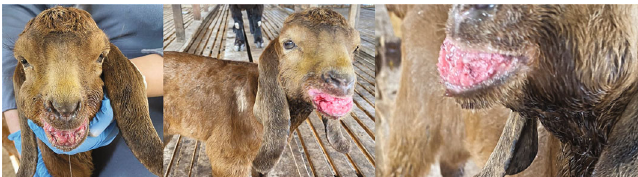
Figure 1: Papillomavirus lesions in the kid showing a mass on the lower lip, buccal mucosa, hard and soft palates, cauli fl ower-like